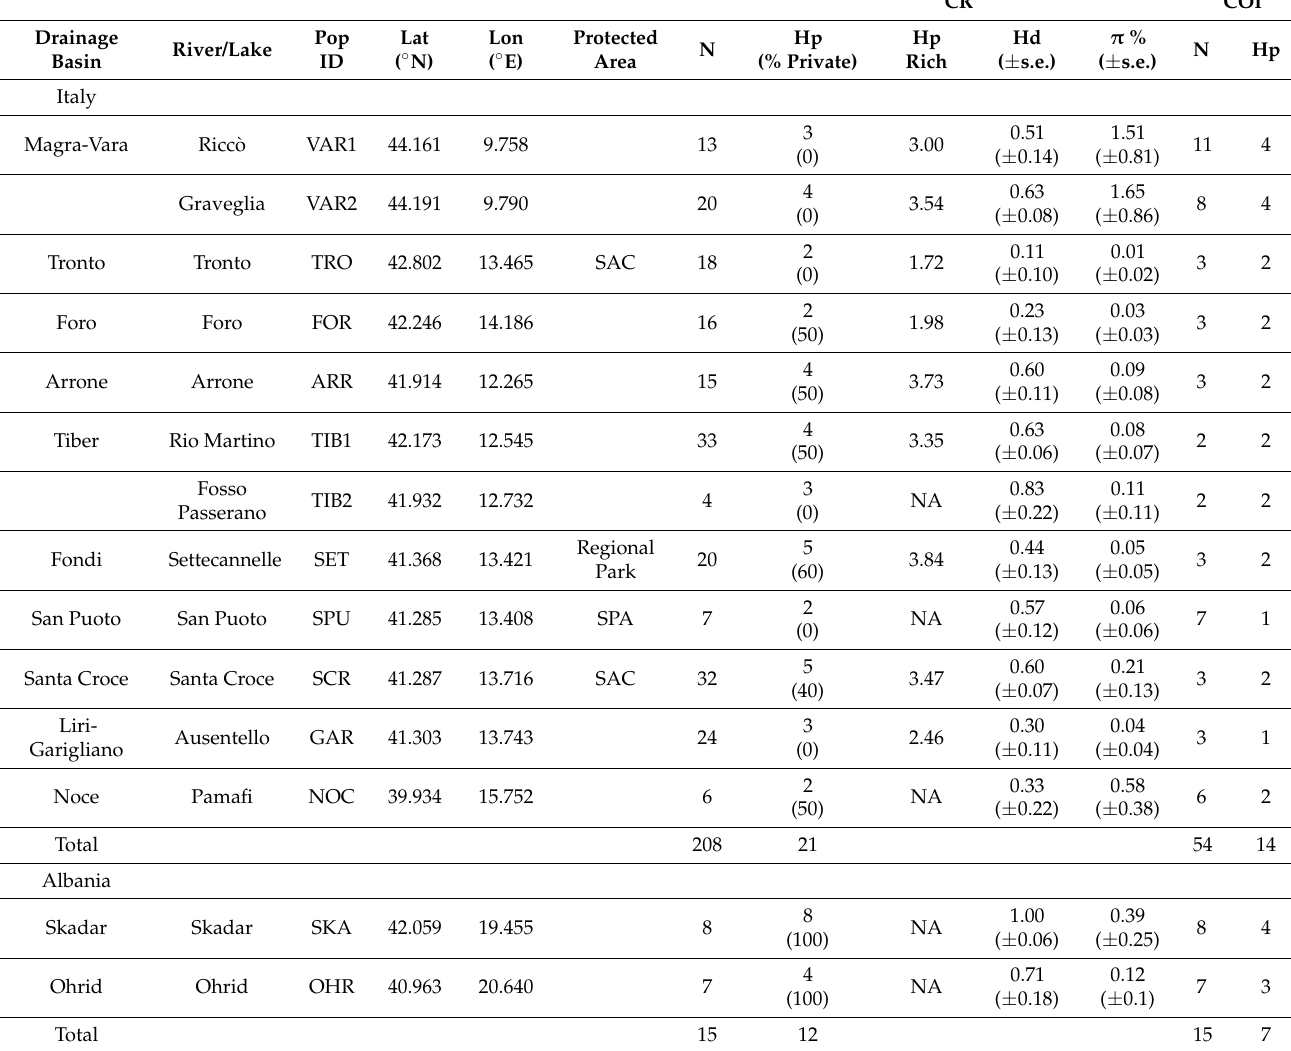
Abbreviations: sample size (N), number of haplotypes and percentage of private haplotypes (Hp), haplotype rich- ness (Hp rich), haplotype diversity (Hd), nucleotide diversity ( π ). Standard errors (s.e.) are given in parentheses for Hd and π . SAC = Special Area of Conservation, according to EC Habitat Directive; SPA = Special Protection Area, according to EC Birds Directive. Datum = WGS84 for geographic